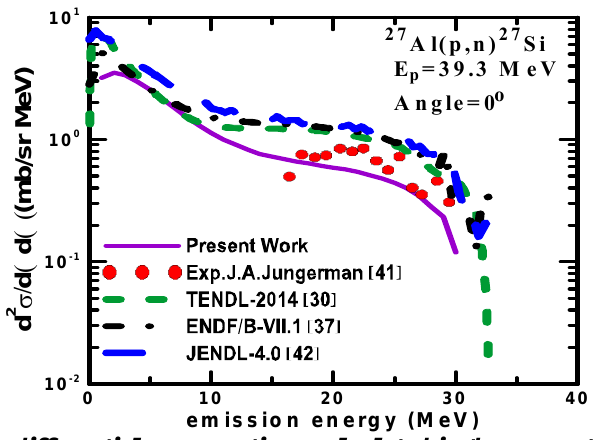
Fig. 10: The double differential cross sections calculated in the present work as a function of emission energy and different emission angle 0 0 for the reaction 27 Al+p and emitted triton at 39.3 MeV compared with experimental data [41] other theoretical results (TENDL [30], ENDF/B-VI [37] and JENDL-4.0 [42]).